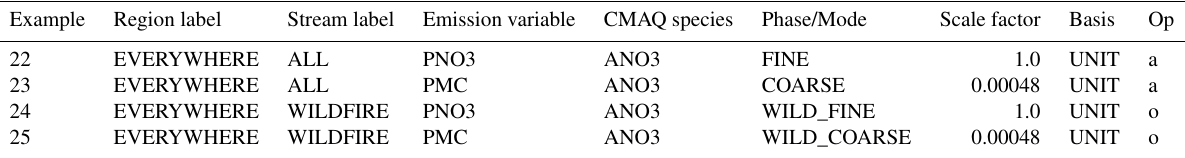
Table 10. Examples of scaling rules using alternative size distributions for primary particulate nitrate emissions.